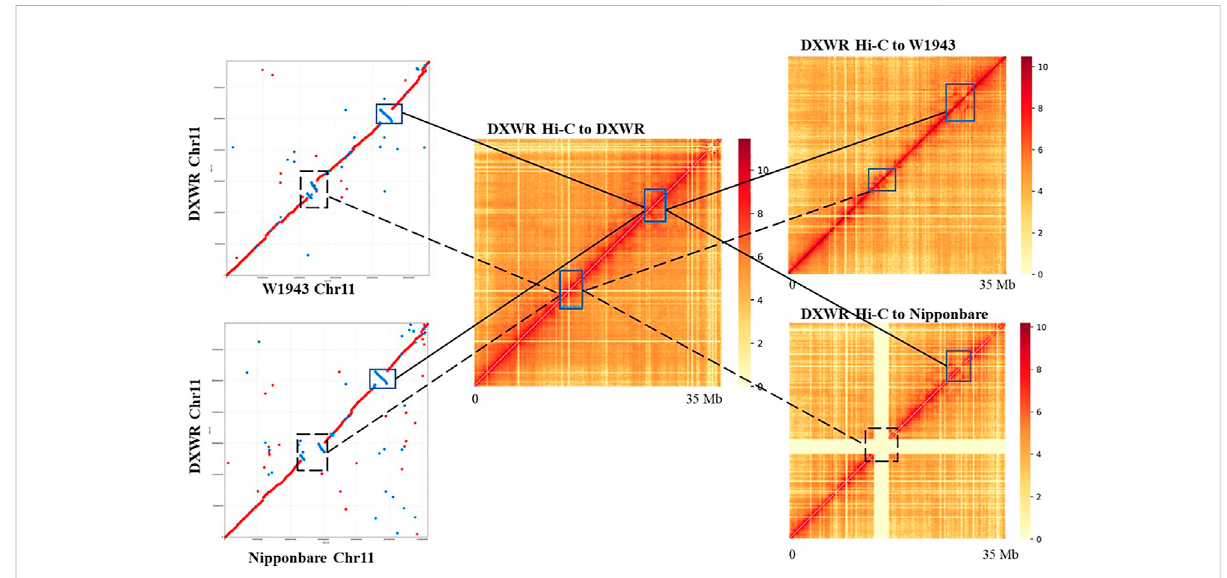
FIGURE 6 The inversions between DXWR and Nipponbare and W1943 supported by Hi-C contact